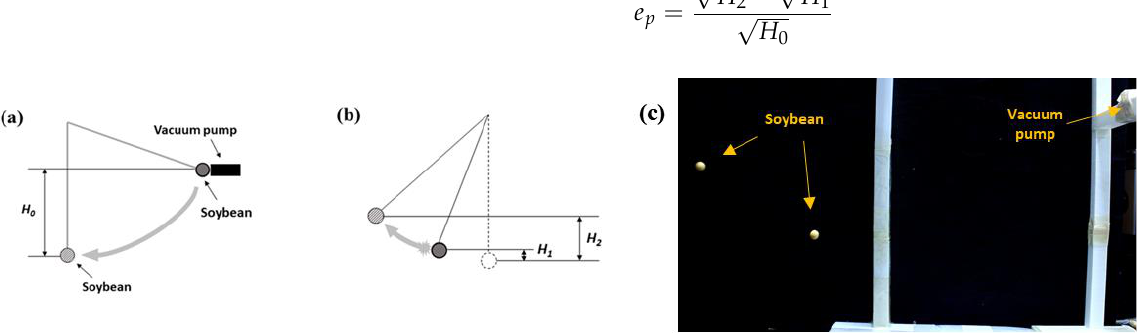
Figure 2. Schematic apparatus and method of determination of the particle – particle coefficient of restitution before ( a ) and after ( b ) impact of the soybeans, and the image taken during the experiment ( c ).